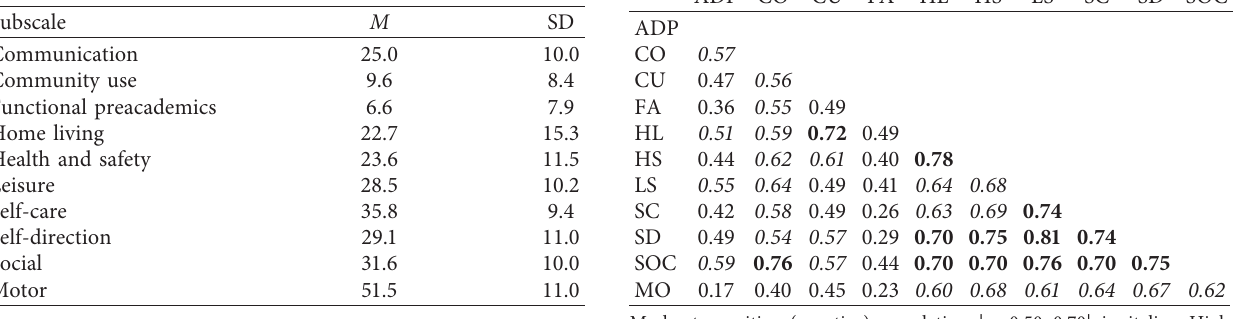
Table 1: Descriptive statistics adaptive behavior subscale raw scores ( N �